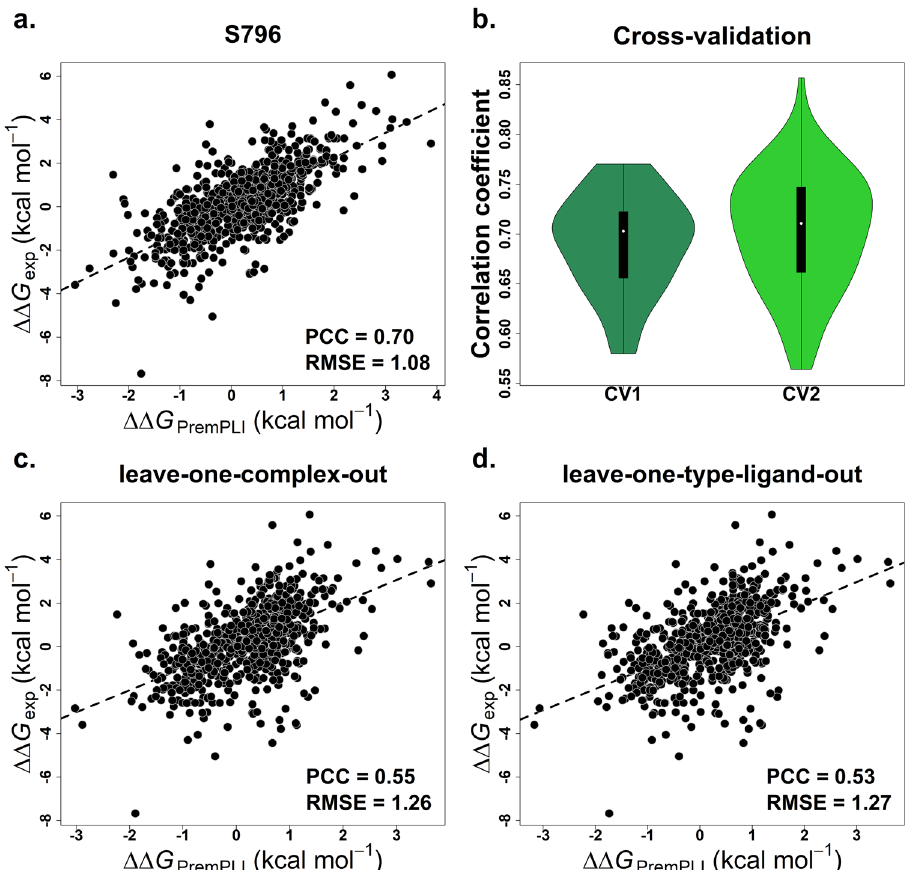
Fig. 3 Pearson correlation coef fi cients between experimental and calculated changes in binding af fi nity. a PremPLI trained and tested on S796 dataset, b ten times 5-fold and 10-fold cross-validations (CV1 and CV2), c leave-one-complex-out validation (CV3), and d leave-one-type-ligand-out validation (CV4). PCC Pearson correlation coef fi cient, RMSE (kcal mol − 1 ) root-mean-square